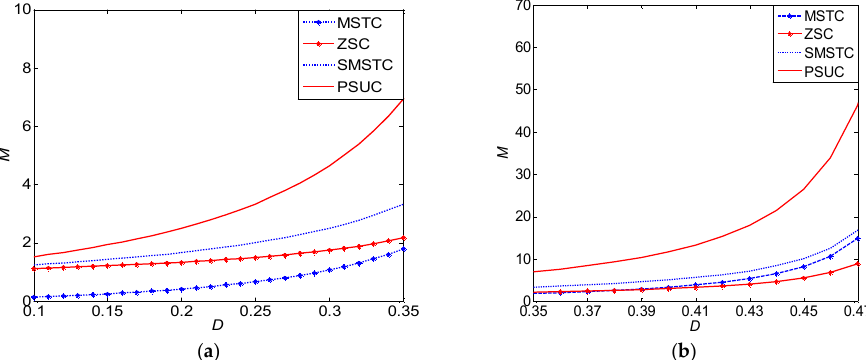
Figure 5. Comparisons about the voltage conversion ratio M among MSTC, ZSC, SMSTC and PSUC. ( a ) D is within 0.1–0.35; ( b ) D is within 0.35–0.47.